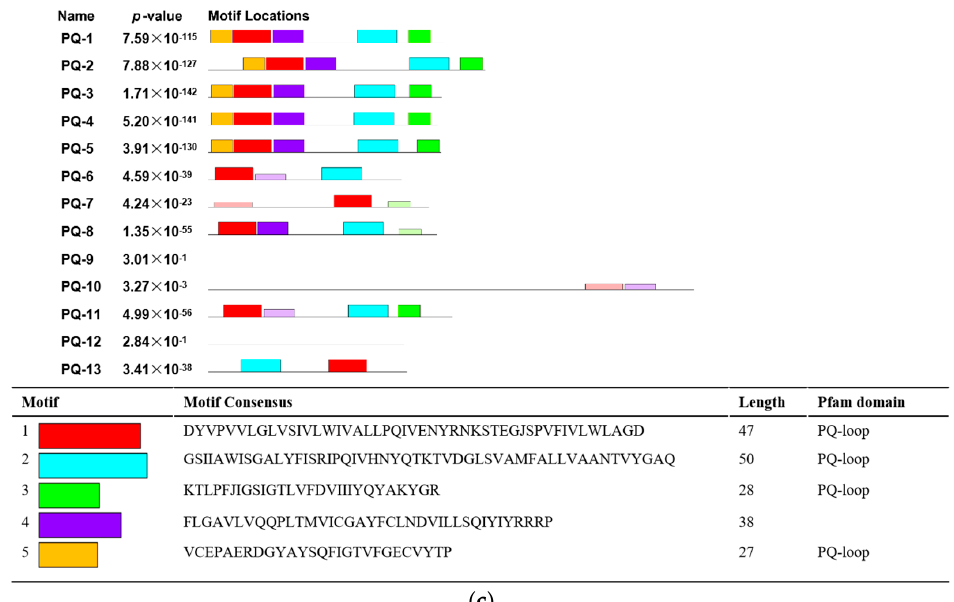
Figure 2. Transmembrane domain structures and distribution of conserved motifs of the sugar transporters in Plasmodiophora brassicae . ( a ) Predicted transmembrane domain structures using TMHMM Server 2.0. Blue lines indicate regions with cytosolic locations, pink lines indicate regions with apoplastic localization, and red boxes indicate putative transmembrane domains. ( b ) Distribution of protein conserved motifs with Sugar-tr domains. ( c ) Distribution of protein-conserved motifs with PQ-loop domains. Conserved motif analysis was performed using MEME 2.0 software, as described in the methods. Each motif is indicated by a colored box numbered from 1 to 5. The lengths of the motifs in each protein were proportional.